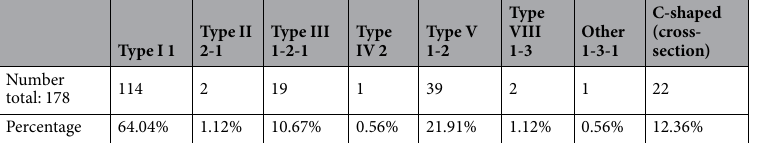
Table 1. Distributions and percentages of categories of variants in the root canal anatomy of mandibular first premolars according to Vertucci’s criteria 21 .